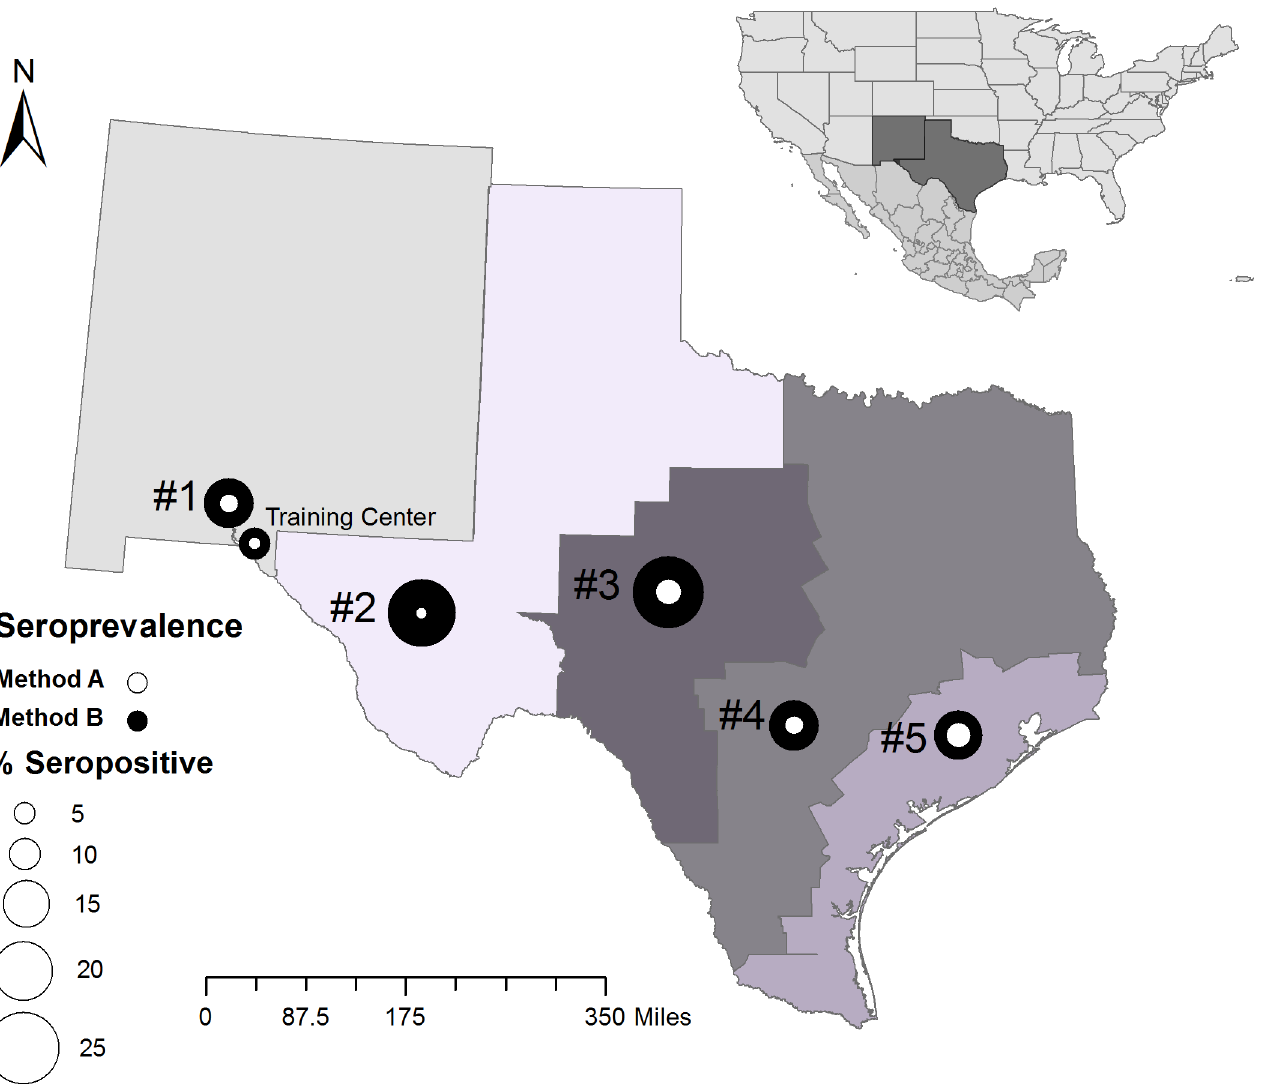
Fig 1. Seroprevalence of government working dogs along the Texas-Mexico border by two methods. Government workingdogs were sampledfrom five management areas (#1–5) and a trainingcenter alongthe Texas-Mexico border in 2015–2016;management area #1 spans New Mexico and Texas. Seroprevalence was calculatedusing Method A- a conservativeanalysisin which very faint serological bandswere interpretedas negative, and Method B- an inclusiveanalysisin which very faint serological bandswere interpretedas positive. Map was created using ArcGIS and with Texas, Mexico, and New Mexico base layers downloaded from www.arcgis.com and the U.S. Department of Commerce, U.S. Census Bureau, Geography Division, Cartographic Products and Services Branch.